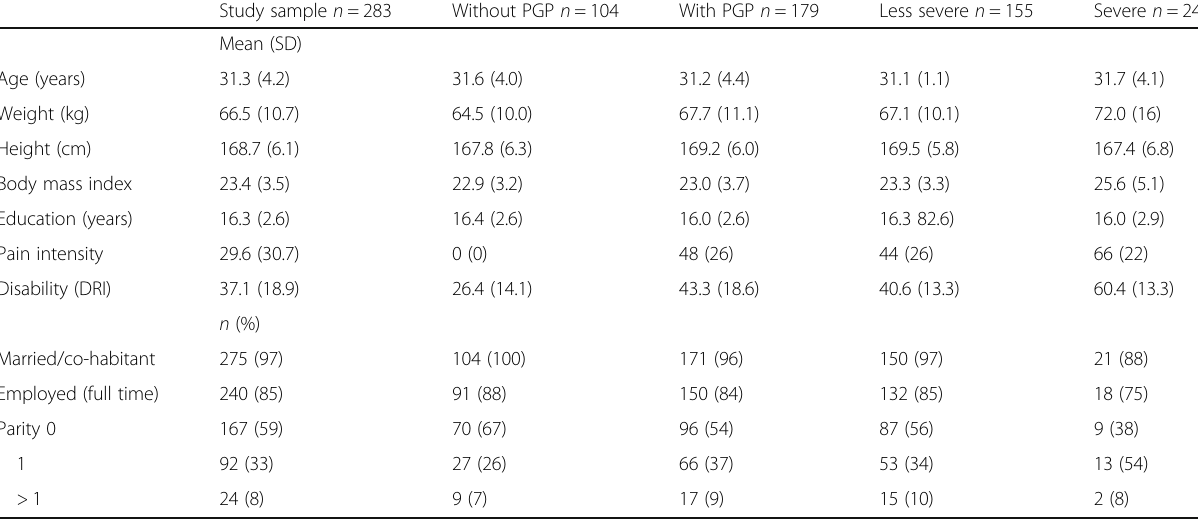
Table 1 Basic characteristics of